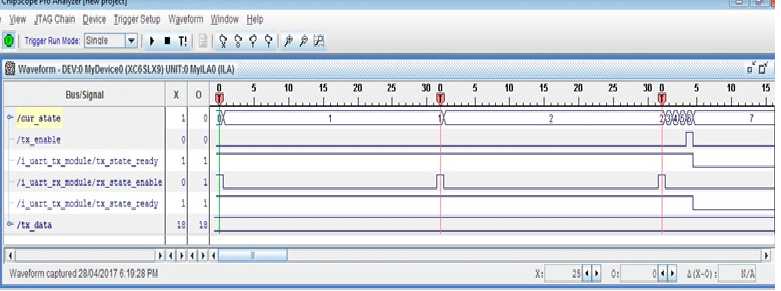
Figure 9. Real-time plot of state transitions during temperature sensing using ChipScope tool.